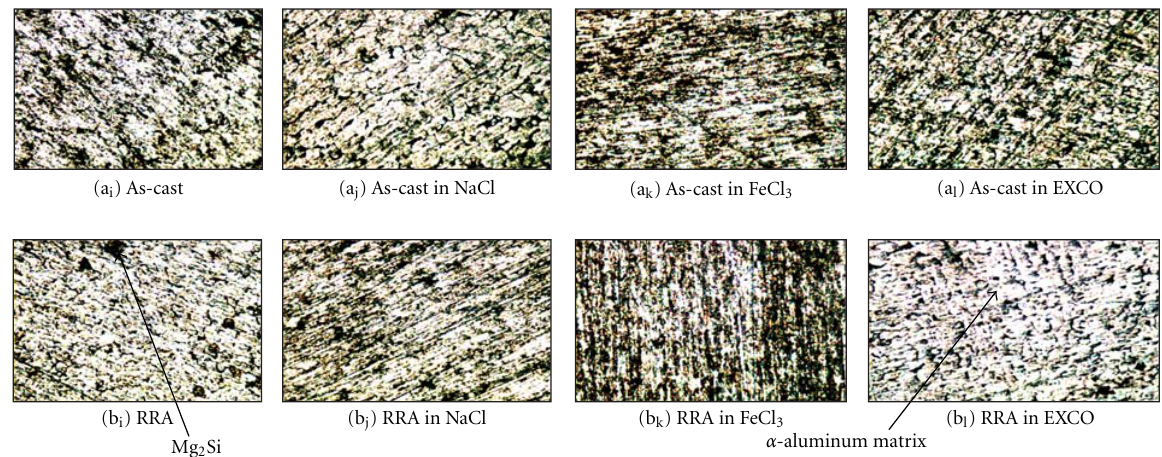
Figure 11: Micrographs of 2.02% Mg addition for untreated (a i –a l ) and treated (b i –b l ) specimens.